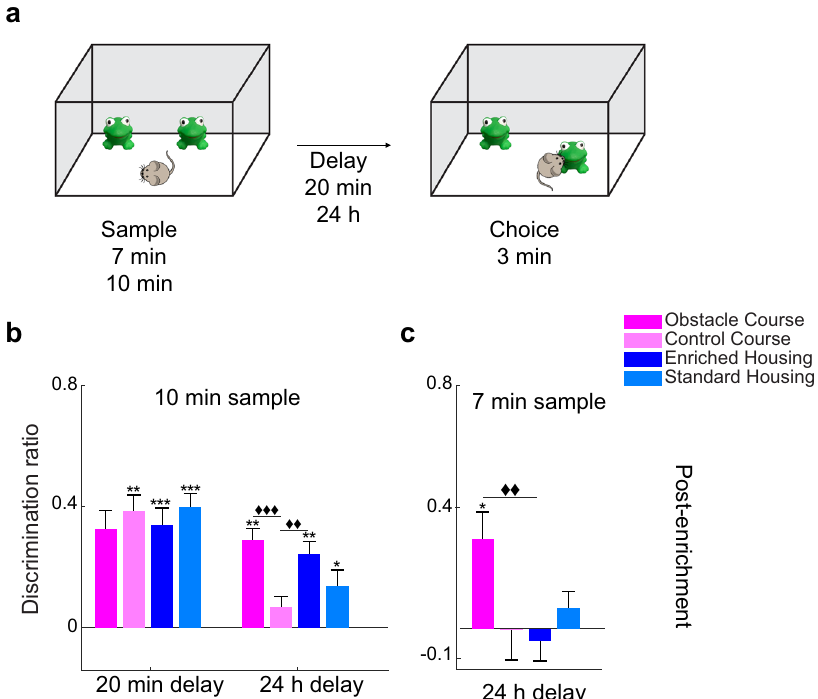
Fig. 3 OLM: enhanced memory for the location with OC training exceeds EH effects. a Schematic of the object location memory (OLM) experiments. b OLM task performance. With a 20-min delay, the CC, EH, and SH groups demonstrated intact spatial memory. With a 24-h delay, the OC and EH groups demonstrated enhanced object location memory, performing signi fi cantly better than the CC group (delay x group interaction p = 0.011, delay main effect p < 0.001, and group main effect p = 0.421). The OC, EH, and SH groups discriminated the displaced object above chance. c Performance with a 7-min sample and 24 h delay. The OC group showed enhanced memory relative to the EH group (Group main effect p = 0.022). Only the OC group discriminated signi fi cantly above chance. The experiment was implemented 5 – 6.5 months post enrichment. * p < 0.05, ** p < 0.01, *** p < 0.001 indicate signi fi cant two-tailed paired-sample t -tests (choice DR vs. sample DR). ♦♦ p < 0.01, ♦♦♦ p < 0.001 indicate a signi fi cant difference between groups (two-tailed independent samples t -test, Bonferroni correction p = 0.0083). Error bars represent s.e.m. across